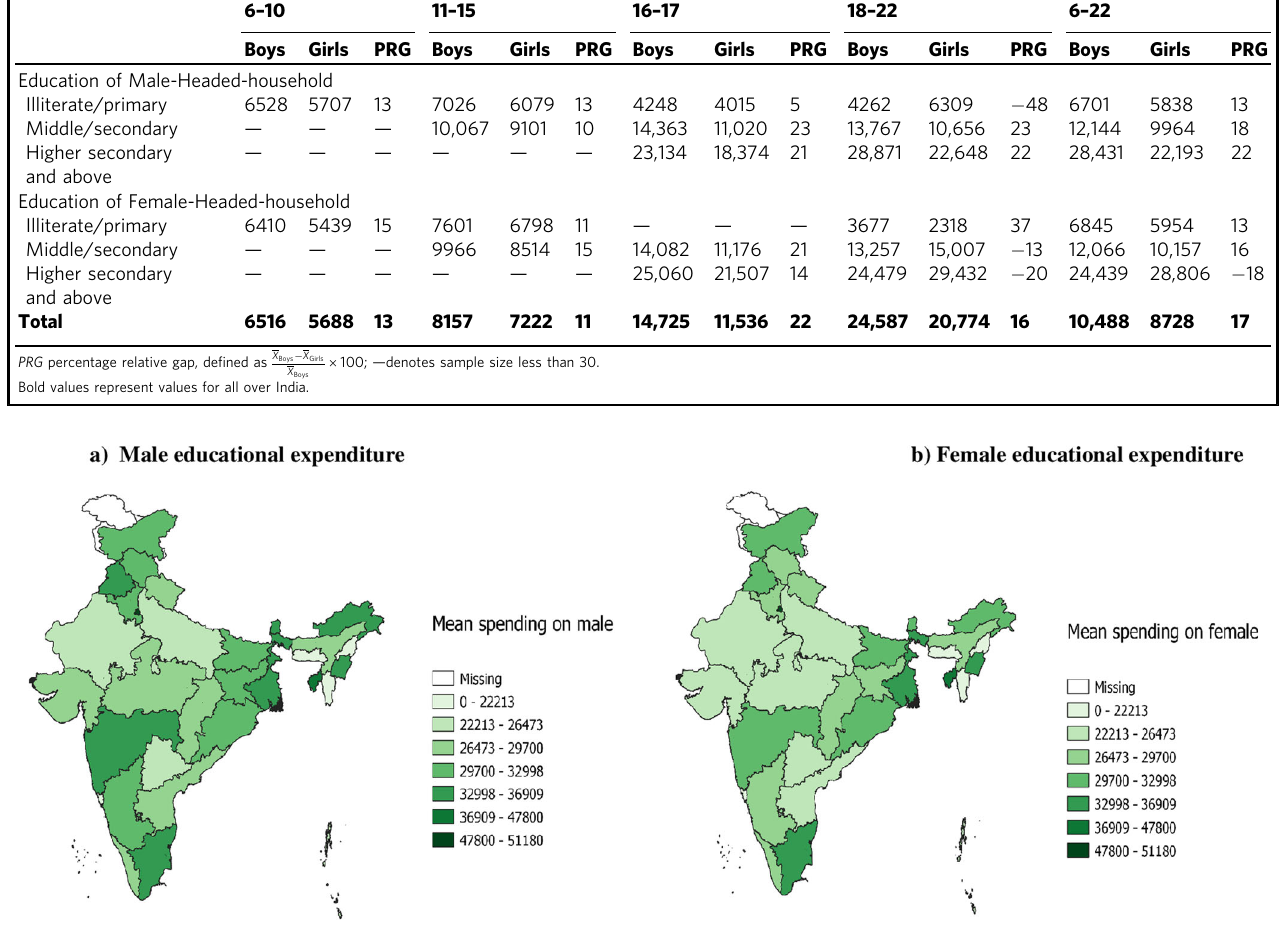
Fig. 4 Adjusted per capita household educational spending (in Rs.) in 16 – 22 years age group during the current academic year of basic course by gender in states of India, 2017 – 18. a Male educational expenditure b Female educational